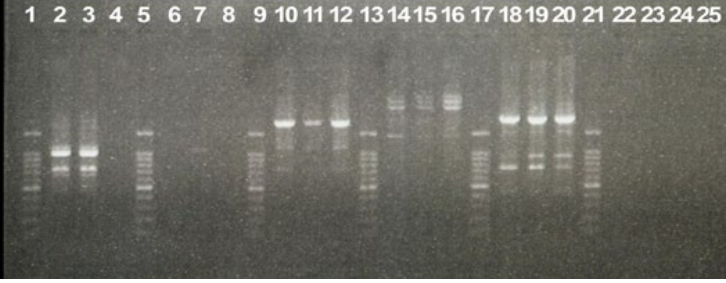
Fig. 3: Electrophoresis results of conjugated products obtained from RAPD-PCR